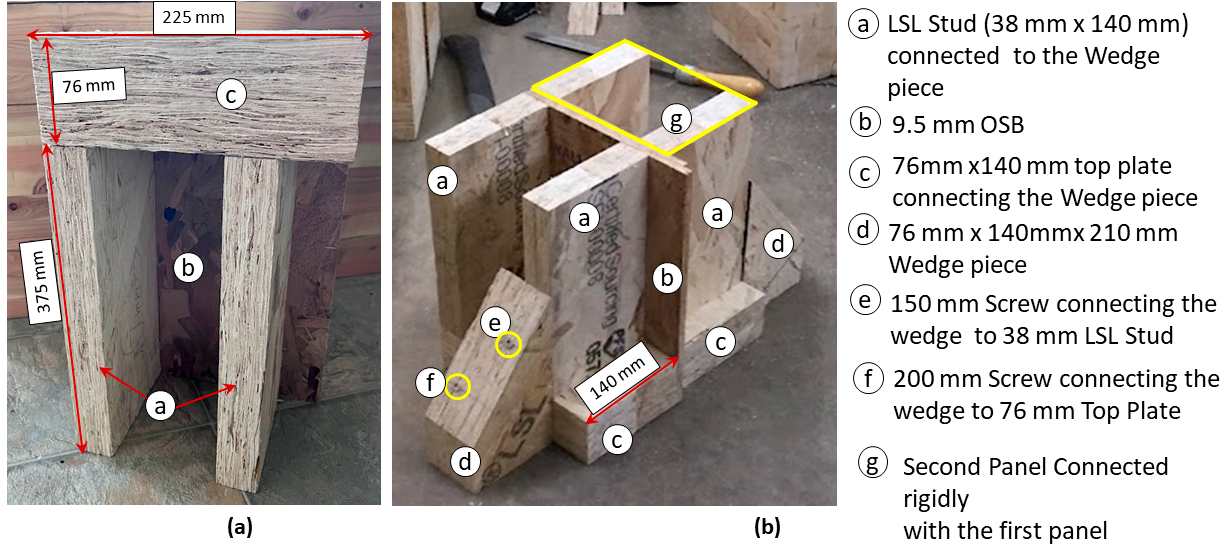
Figure 8. Connection-A specimen.